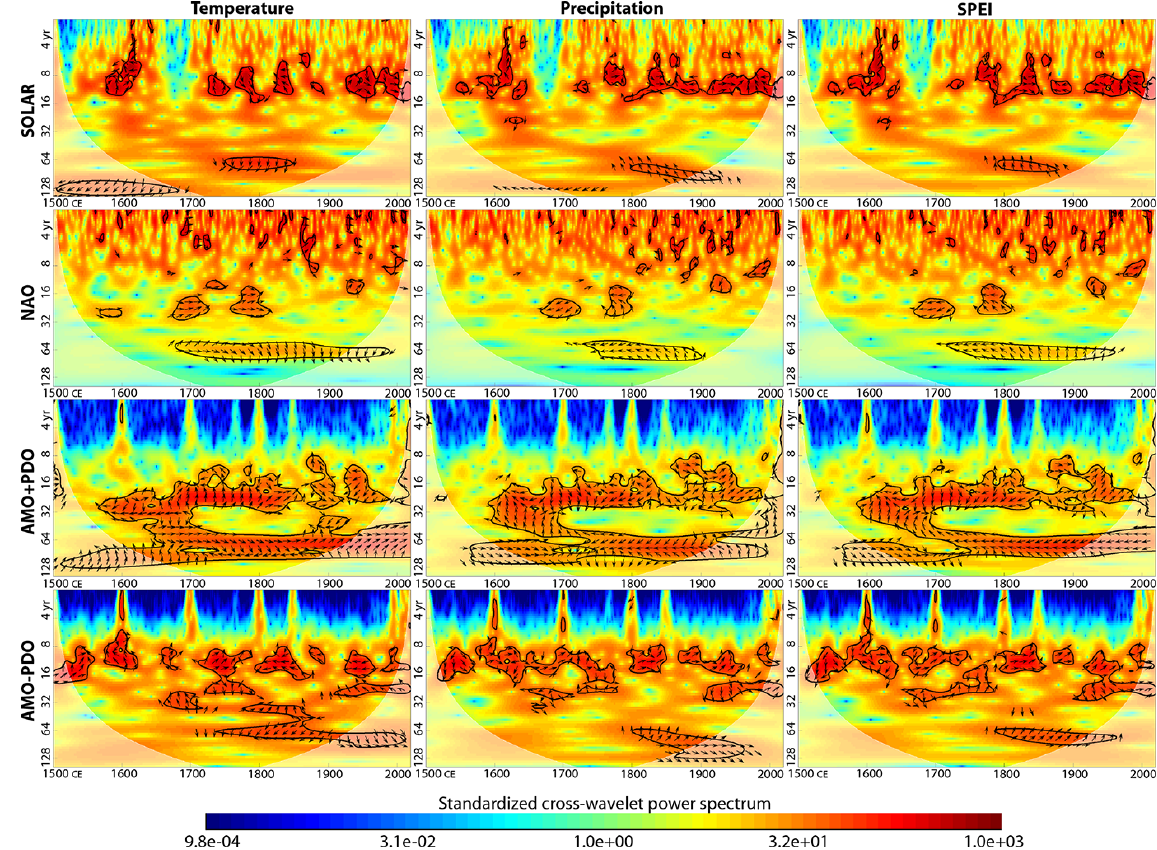
Figure 12. Standardized cross-wavelet spectra between series of temperature, precipitation, or SPEI and explanatory variables with promi- nent oscillatory components (all seasons). Arrows show local phase shifts of the two series (with right-facing arrows corresponding to identical phases); areas with statistically significant oscillations are enclosed by black lines (95% confidence level, AR(1) process null